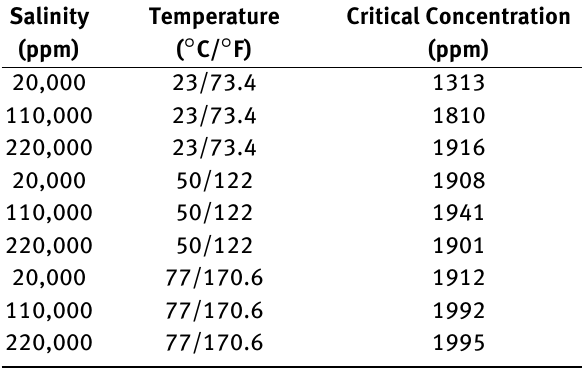
Table 2: Critical concentration